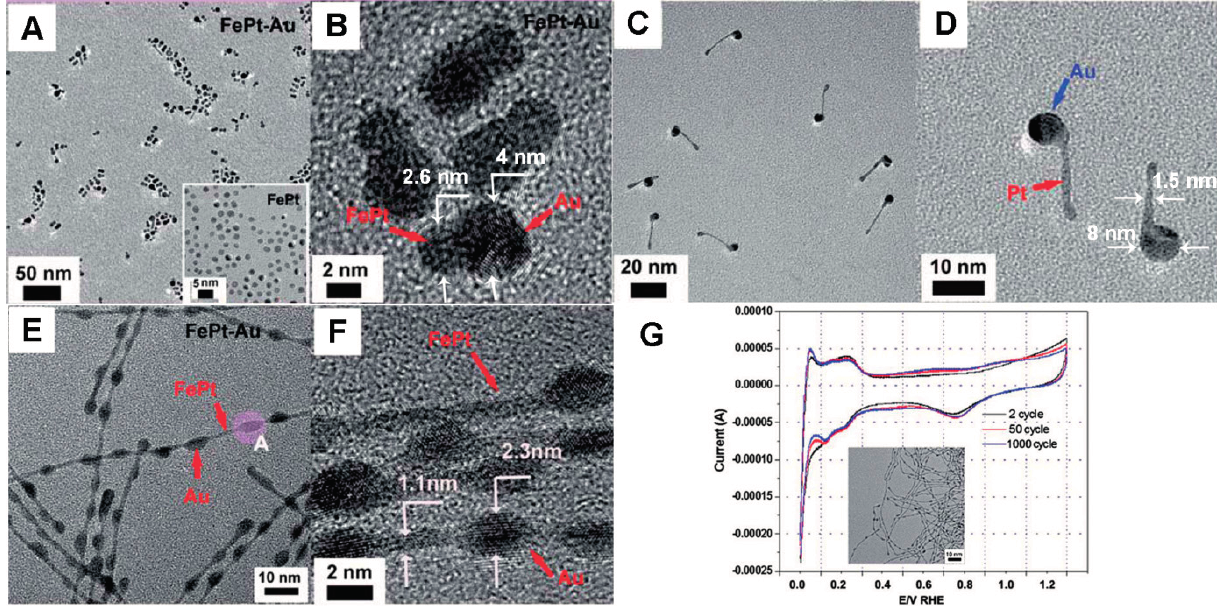
Figure 4. ( A ) The TEM and ( B ) high-resolution TEM image of PtAu heterodimers; ( C ) The TEM and ( D ) high-resolution TEM image of PtAu tadpole-like hybrid structures; ( E ) The TEM and ( F ) high-resolution TEM image of PtAu necklace-like hybrid structures; ( G ) The oxygen-reduction reaction using PtAu necklace-like hybrid structures as electrocatalysts